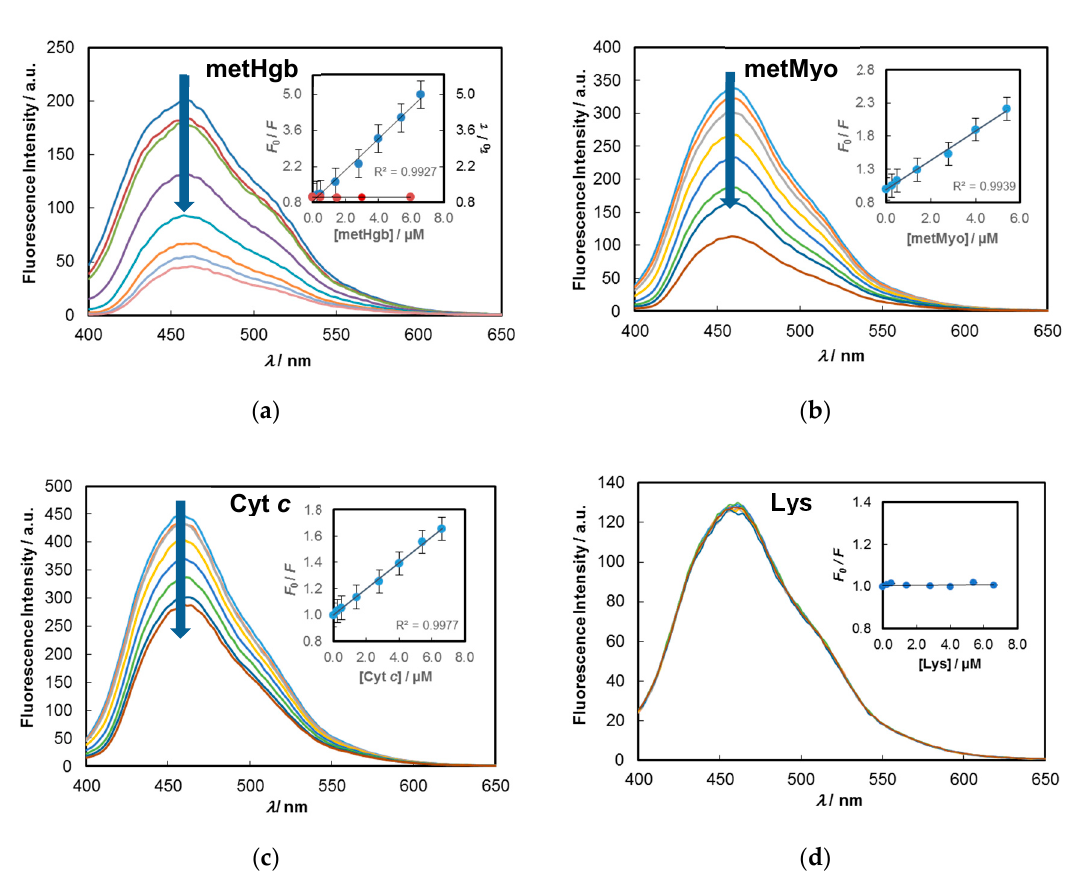
Figure 4. Emission spectra of C-dots (0.2 mg/mL) upon varying the amount of added protein (0, 0.25, 0.5, 1.4, 2.8, 4.0, 5.4, 6.6 µM) in phosphate buffer solution at 25 °C (pH = 7.2). Inset ( a ): Stern–Volmer plots obtained from steady-state (blue dots; F 0 / F ; λ exc = 380 nm) and time-resolved (red dots; τ 0 / τ ; λ exc = 340 nm) fluorescence data. Insets ( b – d ): Stern–Volmer plots from steady-state data ( λ exc Error bars indicate the standard